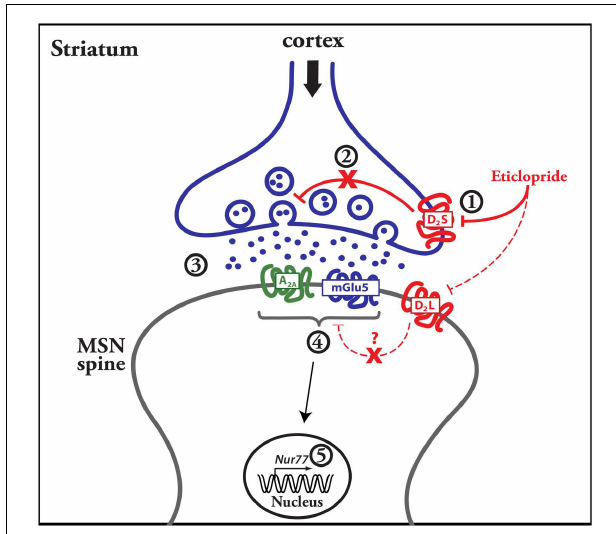
FIGURE 7 | Suggested events leading to the modulation of striatal gene transcription by a dopamine D 2 antagonist. The figure includes a schematic representation of a striatal medium spiny neuron (MSN) with a glutamatergic terminal coming from the cortex. Data presented herein suggest that the dopamine D 2 antagonist blocks presynaptic D 2 heteroreceptors (D 2S ) located on glutamatergic terminals, which control glutamate release (step 1 and 2).This leads to an elevation of glutamate contents in the synapse (step 3), which in turn activate postsynaptic metabotropic mGlu5 and adenosine A 2A receptors (step 4). Intracellular signaling events associated with activation of mGlu5 receptors (in addition to adenosine A 2A receptors) then lead to the increase of Nur77 gene transcription in MSNs (step 5).The dash line and question mark that link postsynaptic D 2L and A 2A -mGlu5 receptors illustrate the fact that we were unable to show a contribution of postsynaptic dopamine D 2 receptors in the transcriptional effect of mGlu5/A 2A receptor agonists in our organotypic slice